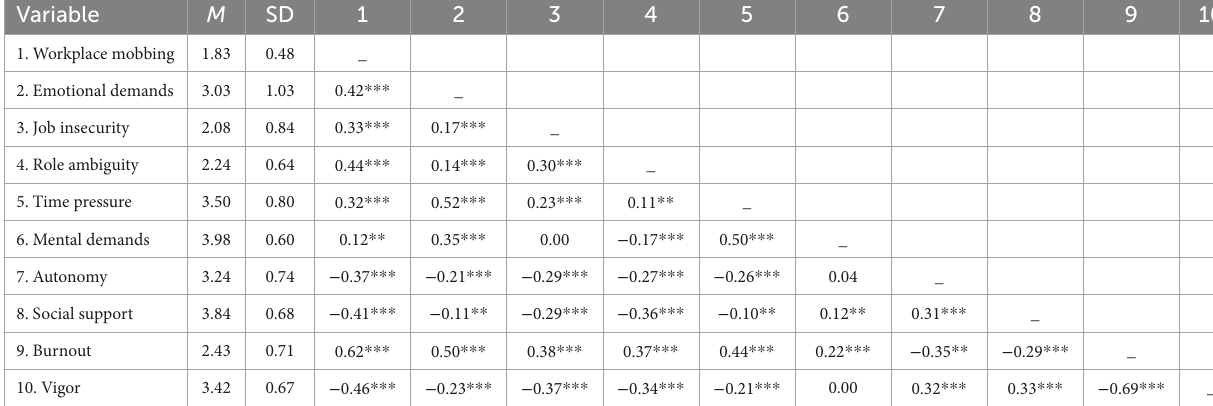
TABLE 1 Means, standard deviations, and inter-correlations among latent variables.